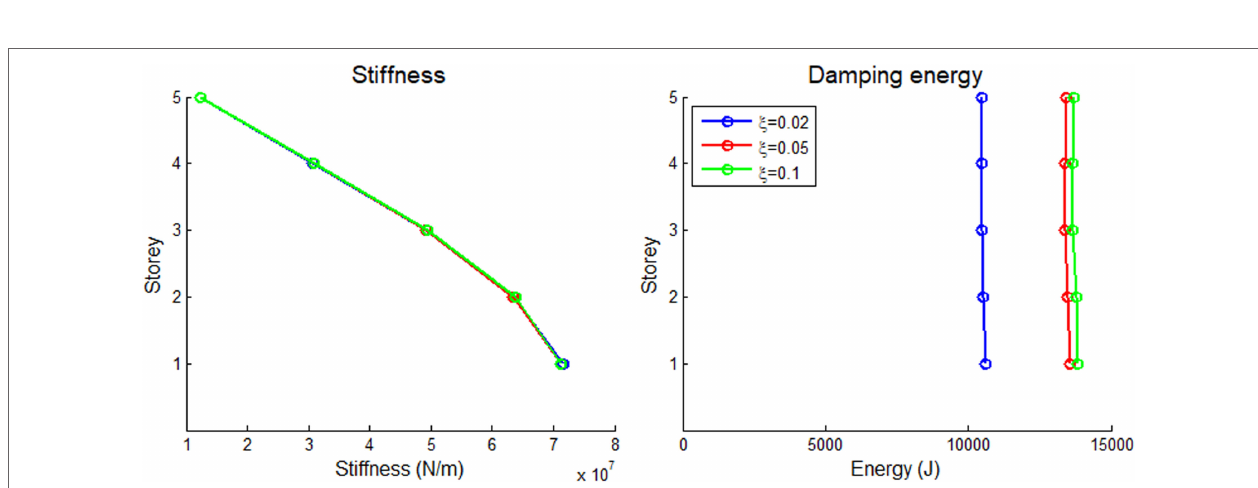
FIGURE 6 | Optimum distributions of elastic stiffness and energy dissipated due to damping for the 5-storey shear building subject to the El Centro earthquake record for various critical modal damping